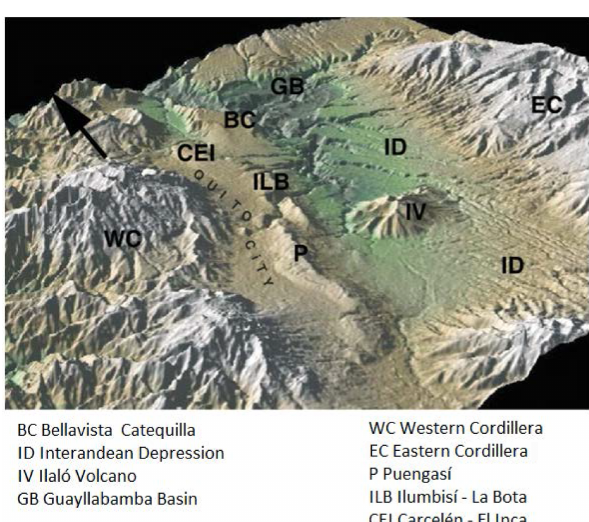
Figure 2. 3-D view of the Andean valleys (Alvarado et al., 2014).